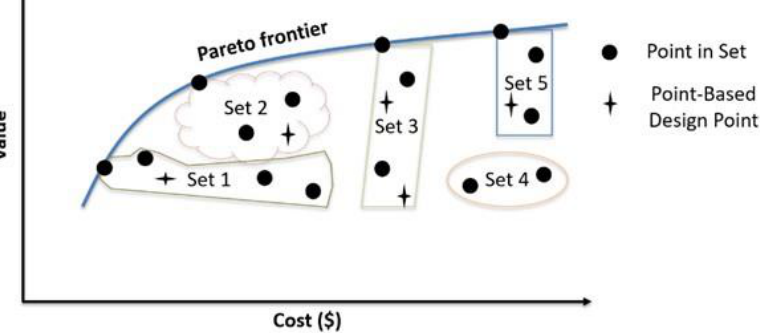
Figure 1. PBD (point-based design) and SBD (set-based design) Tradespace Comparison [16].